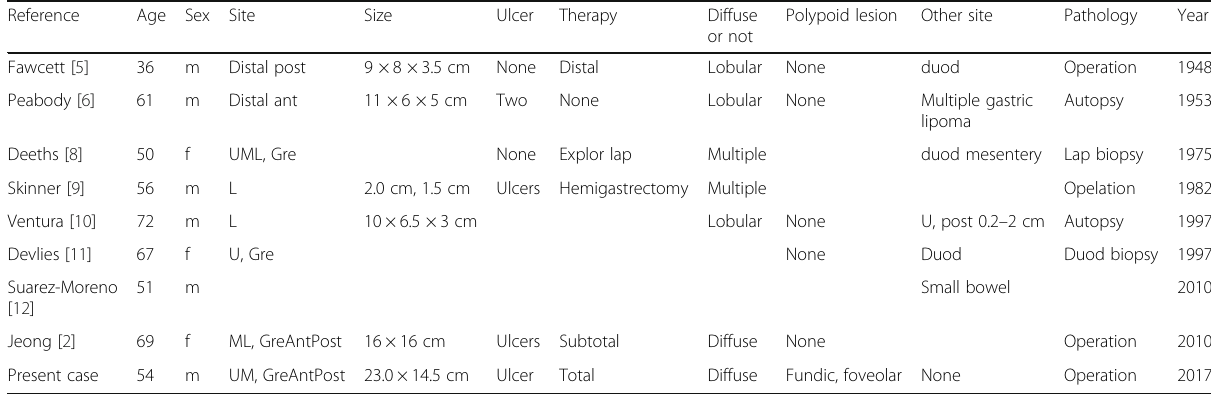
Table 1 Case of gastric lipomatosis